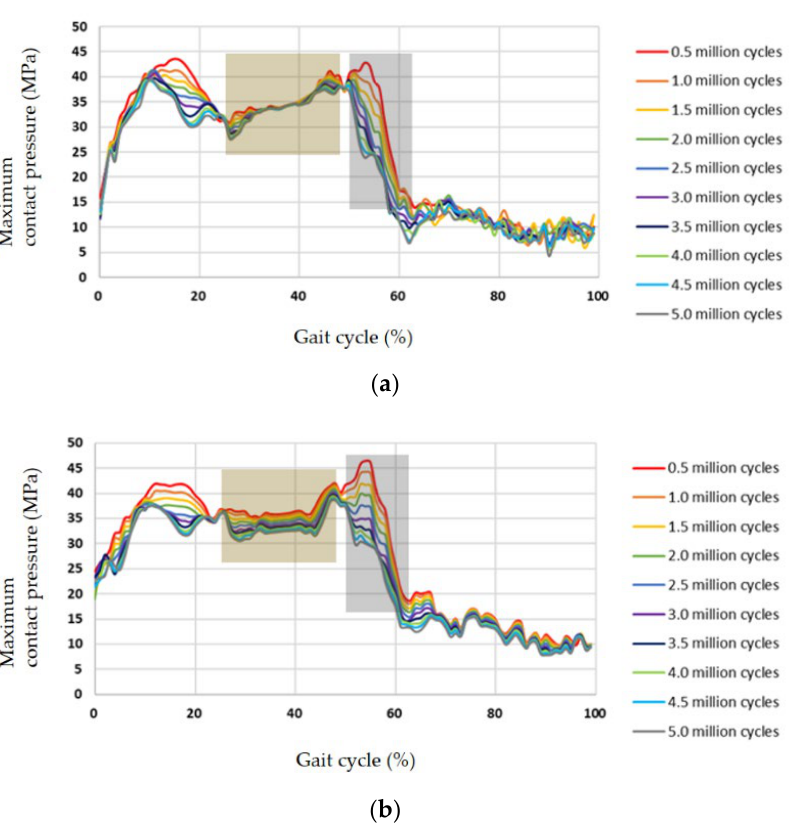
Figure 13. Comparison of maximum contact pressure variation during 5,000,000 cycles in two gait mechanisms:( a ) Normal gait mechanism; ( b ) Flatback gait mechanism. mechanisms: ( a ) Normal gait mechanism; ( b ) Flatback gait